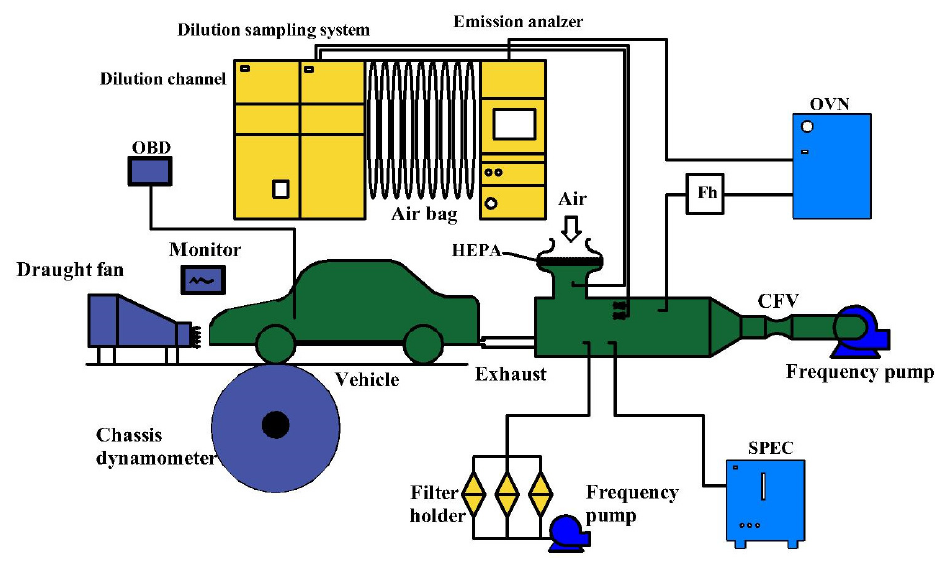
Figure 1. The schematic diagram of the chassis dynamometer. CFV = critical flow venturi; HEPA = high efficiency particulate air filter; OVN = oven type heated analyzer. Table 2. Main test equipment.